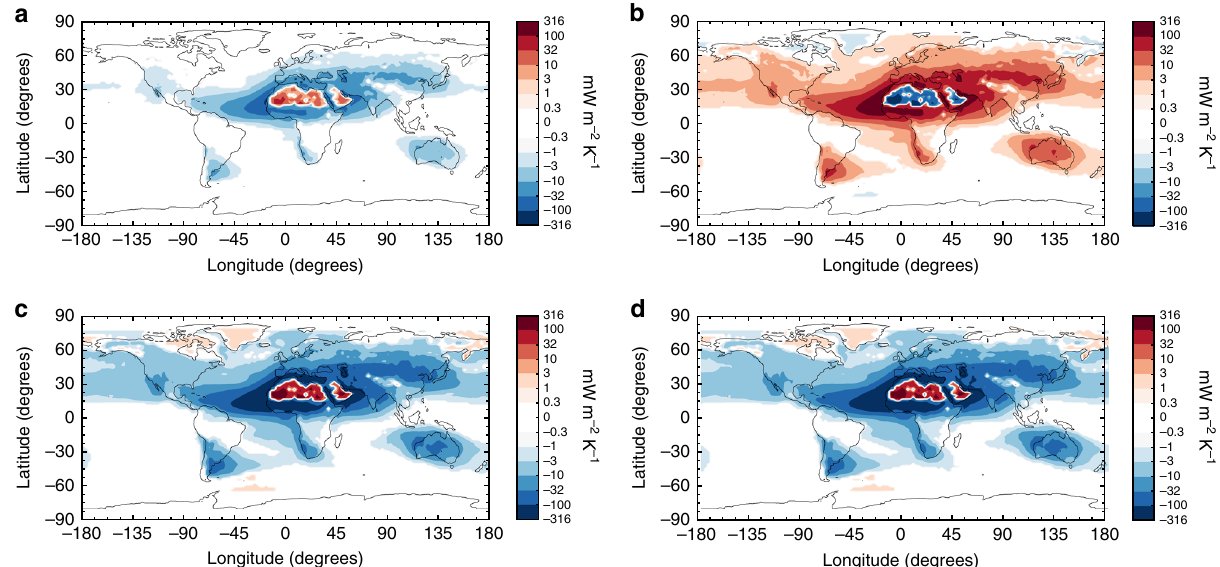
(cid:1) (cid:3) obtained using the median, the lower 95%